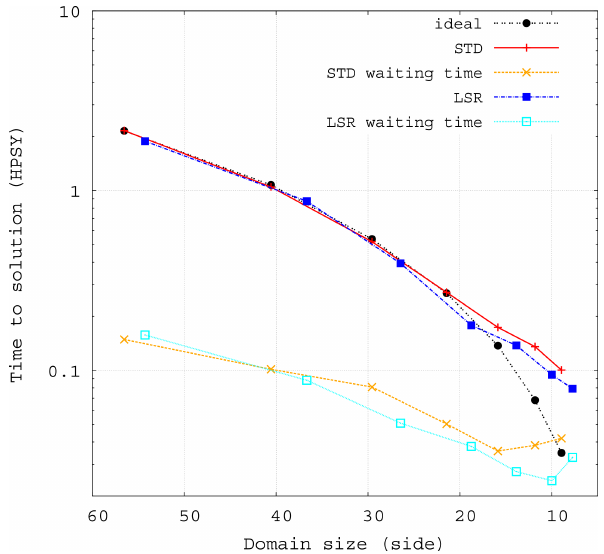
BENCH the ORCA periodic characteristics and reproduces the same communication pattern between subdomains lo- cated on the northernmost part of the grid.